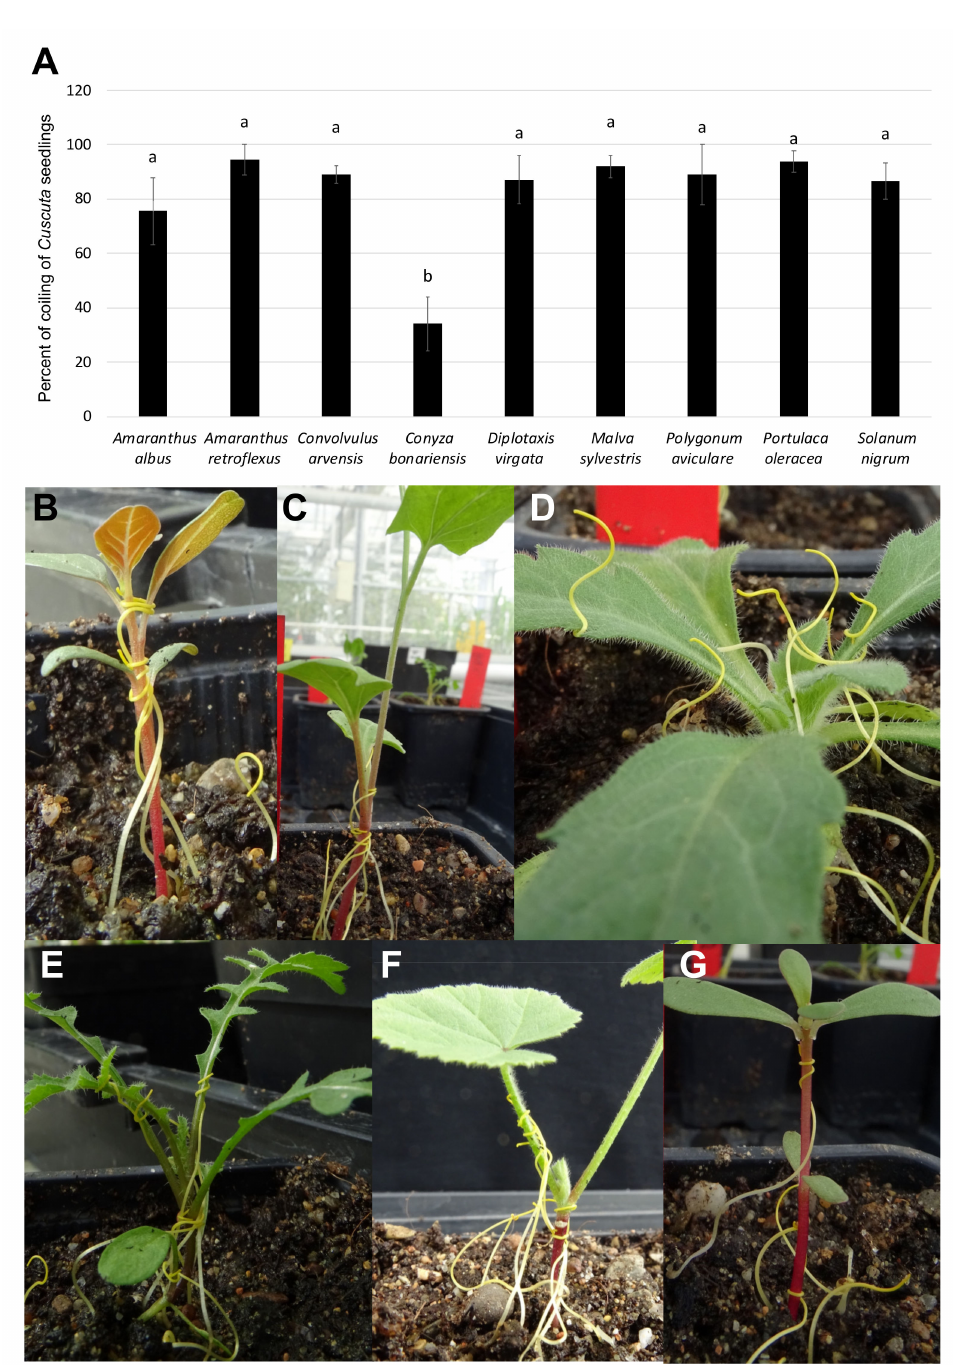
Figure 3. Compatibility of seven day-old Cuscuta campestris seedlings with a collection of 9 weed species. ( A ) Percentage of Cuscuta seedlings that coiled around weed plants, and illustrative pho- tographs showing the coiling of Cuscuta seedlings on the stems of ( B ) Amaranthus albus ; ( C ) Convolvu- lus arvensis ; ( D ) Conyza bonariensis ; ( E ) Diplotaxis virgata ; ( F ) Malva sylvestris ; ( G ) Portulaca oleracea . Treatments with different letters are significantly different according to the Tukey test ( p = 0.05). Error bars represent the standard error of the